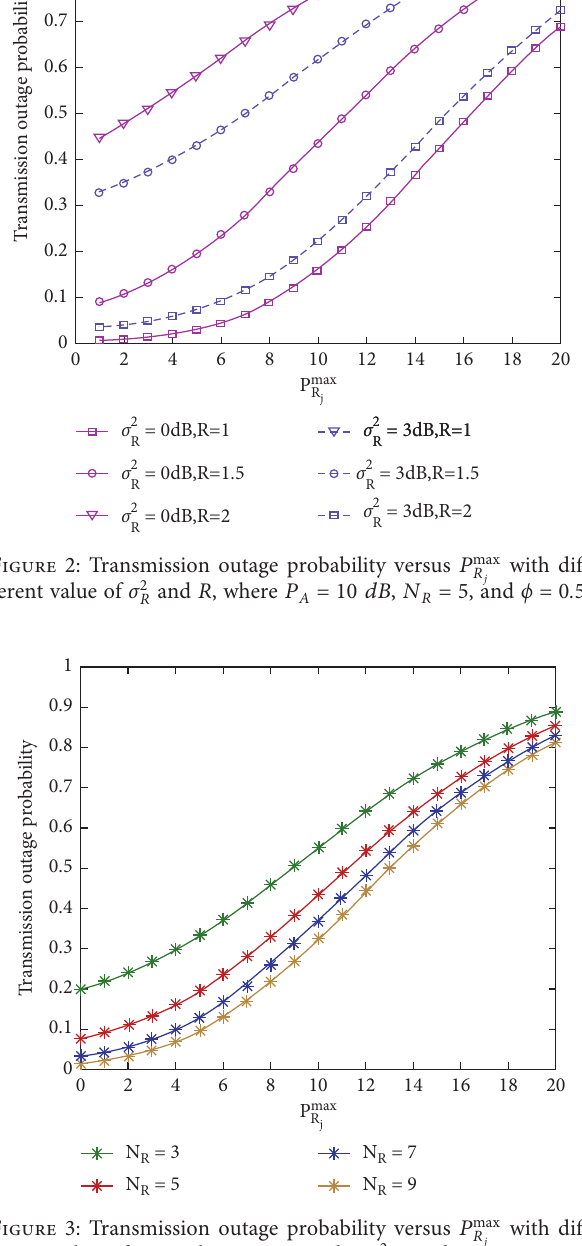
Figure 3: Transmission outage probability versus P max ferent value of N R , where P A � 10 dB , σ 2 R � 0 dB , R � 1 . 5, and ϕ � 0 . 5.